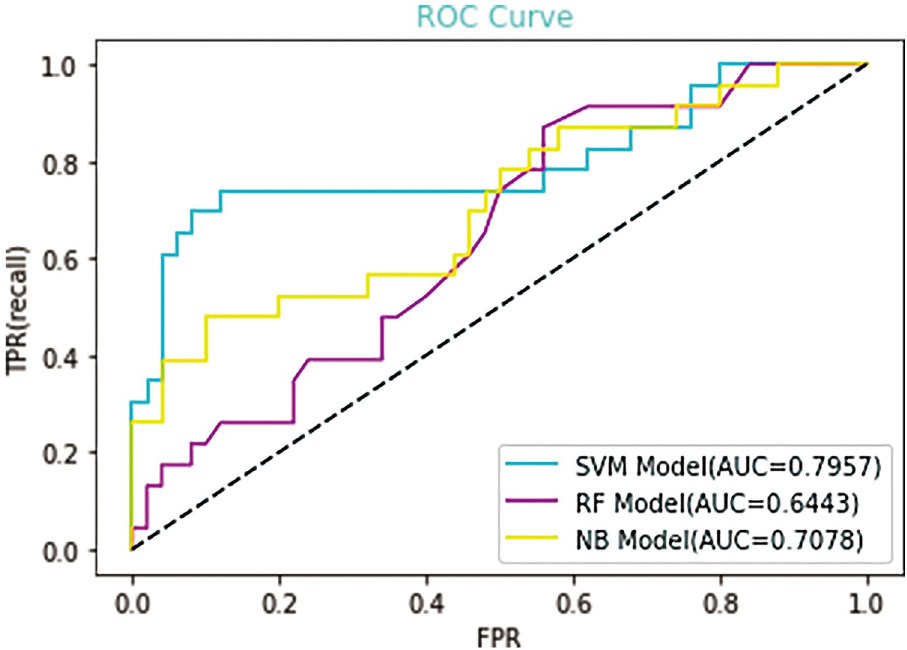
Fig 4. Receiver operating characteristic (ROC) curves of the three candidate models for the prognosis of IgAN. AUC, area under the curve.